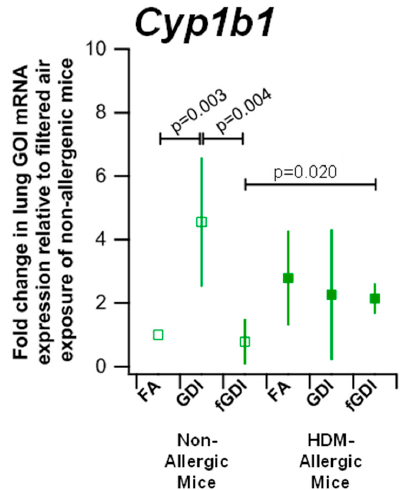
Figure 4. Enhanced expression of Cyp1b1 following GDI engine exhaust exposure in non-allergic animals. Cyp1b1 mRNA expression was measured in lung homogenates from naïve mice (non-allergic, open squares) and mice with airway hyperresponsiveness (HDM allergic, filled squares) exposed to HEPA filtered air (FA), GDI engine exhaust, or filtered GDI engine exhaust (fGDI). Genes of interest (GOI) transcript expression were normalized to Ppia expression and expressed as a fold change relative to the FA exposed non-allergic mice exposed. Means ± SDs are shown from 5 mice per group. Tnf α and Cxcl1 , the murine homologue of the Il8 transcript in humans, are markers of inflammation (Figure 5, Table S2). Baseline expression of both Tnf α and Cxcl1 was increased in HDM-allergic animals compared to non-allergic animals. However, no difference was found across exposure groups for these two inflammatory markers in HDM-allergic animals. The gene expression of Tnf α was elevated in non-allergic mice exposed to GDI engine exhaust (9.40, SD = 4.97) compared to those exposed to HEPA filtered air ( p = 0.004) and f-GDI engine exhaust (1.56, SD = 1.34; p = 0.008). Moreover, upregulated Cxcl1 expression was found in non-allergic animals exposed to GDI engine exhaust (4.85, SD = 2.22; p = 0.005) relative to non-allergic animals exposed to HEPA filtered air and f-GDI engine exhaust (1.67, SD = 1.08; p = 0.023).